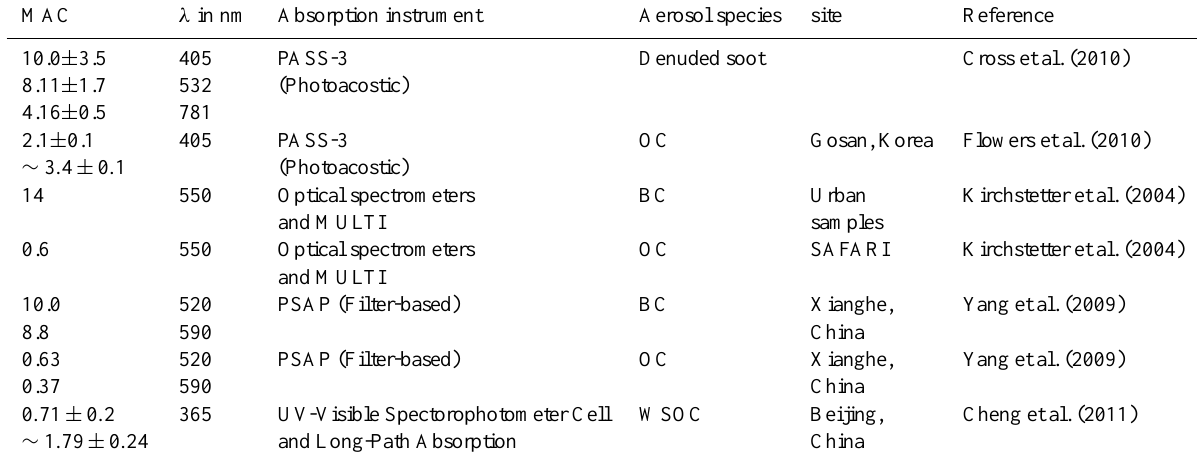
Table 1. Reported ambient aerosol Mass Absorption Cross section (MAC) in units of m 2 g − 1 . The gram unit in MAC here is for carbon. For BC MAC, the carbon mass is for its EC component only. Some studies of estimating BC MAC (e.g. Clarke et al., 2004; Quinn et al., 2004) attributed all the CA absorption to BC absorption, and we exclude such studies here. For OC MAC here, the carbon mass includes BC-intrinsic OC, and the absorption is due to organic material in the